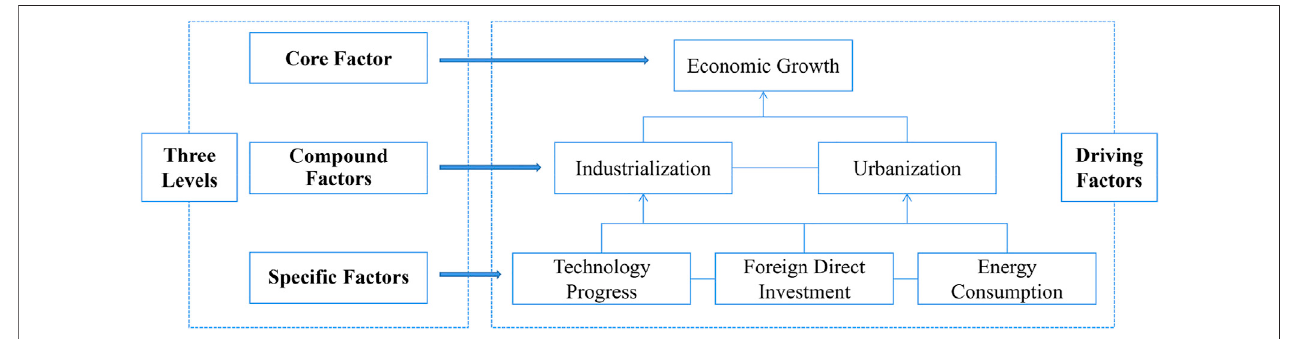
FIGURE 1 | The framework of driving factors on CO 2